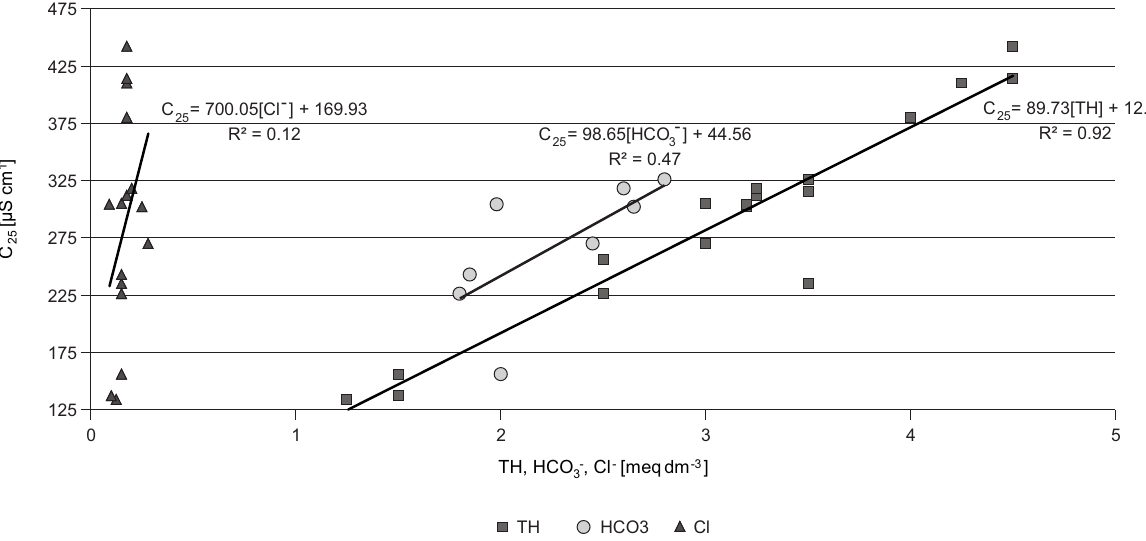
Fig. 8. Electrical conductivity (C25) in the stream of the CT-2 study catchment as a function of concentration of Cl - and HCO 3- and total hardness